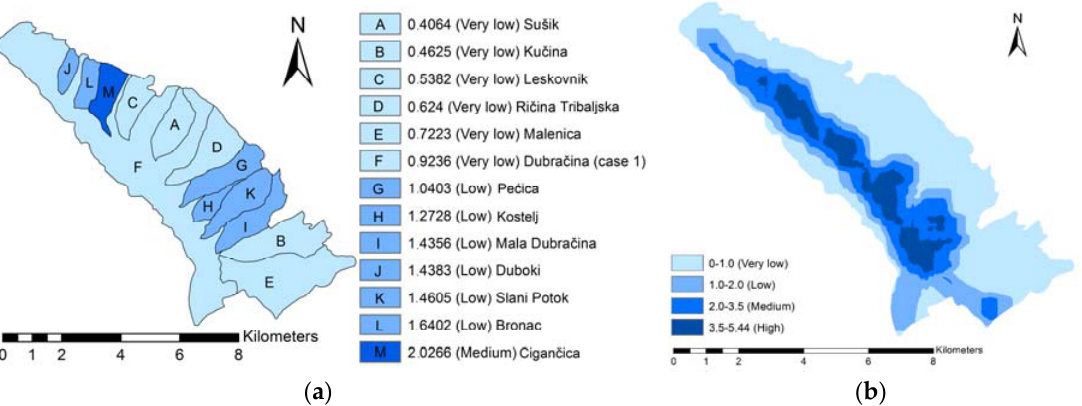
Figure 2. Drainage density for the Dubra č ina catchment: ( a ) Case 2: sub ‐ catchment; ( b ) Case 3: spatial variability using Dobos and Daroussin [7]